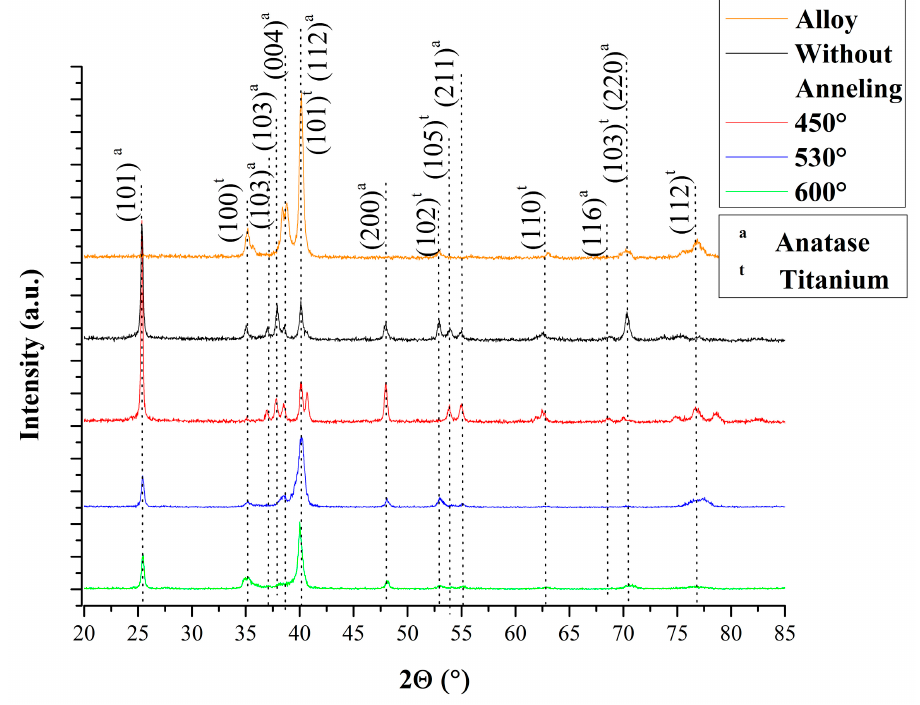
Figure 2. XRD of Ti–30Ta alloy surface before and after nanotubes of TiO2 growth in 0.25% NH 4 F + glycerol at 30 V for 9 h. Group 1—Ti–30Ta alloy without surface modification, Group 2—anodized without annealing, Group 3—450 ◦ C-nanotubes of TiO 2 annealed at 450 ◦ C, Group 4—530 ◦ C-nanotubes of TiO 2 annealed at 530 ◦ C annealed and group 5—600 ◦ C-nanotubes of TiO 2 annealed at 600 ◦